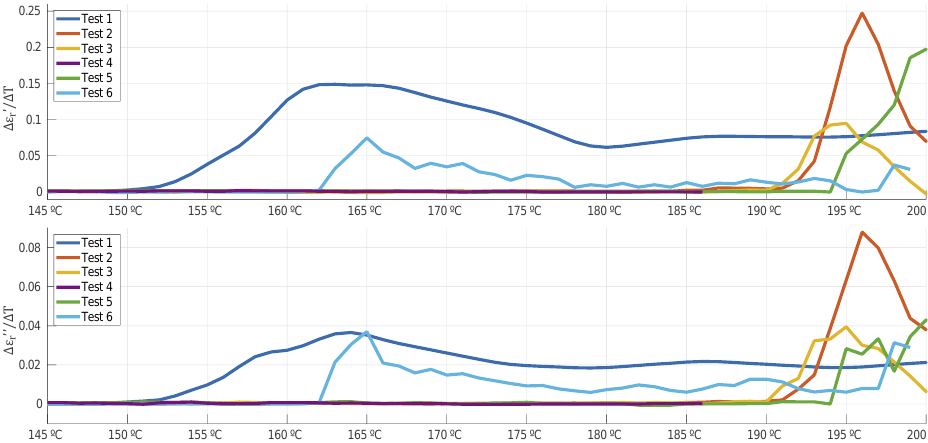
Figure 9. Dielectric constant and loss factor gradients versus temperature (resolution ∆𝑇 = 1℃ ).